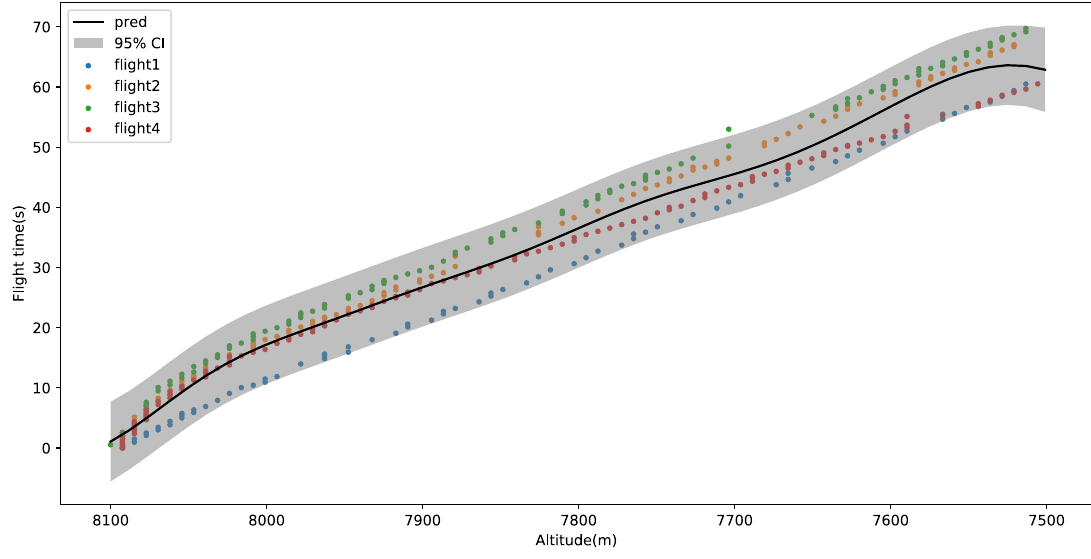
Figure 13. The predicted flight time of its CI for a descent flight from 8100 to 7500 m.